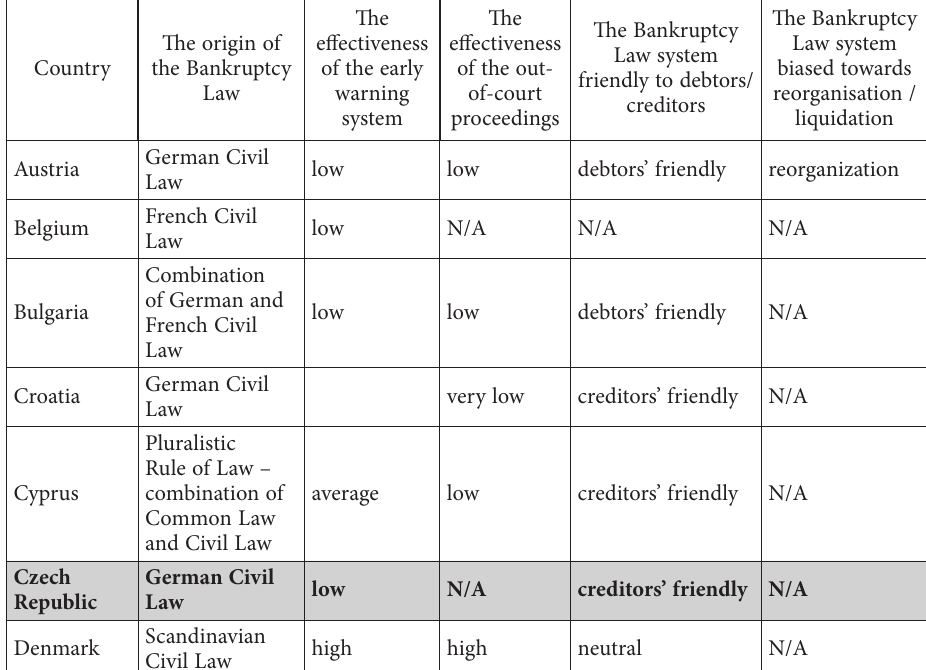
Table 9. The characteristics of bankruptcy systems in selected European countries (source: European Commission, 2011)